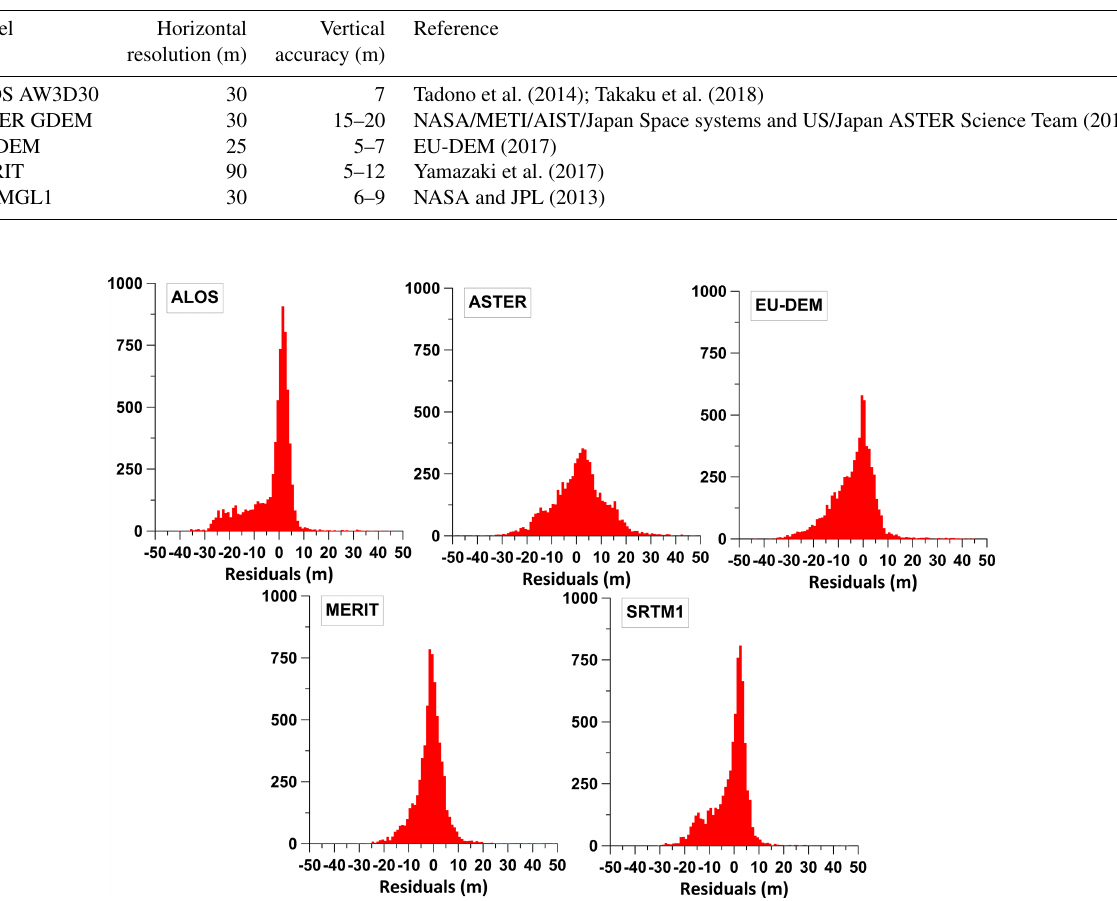
Table C3. Basic characteristics of the global DEMs tested.